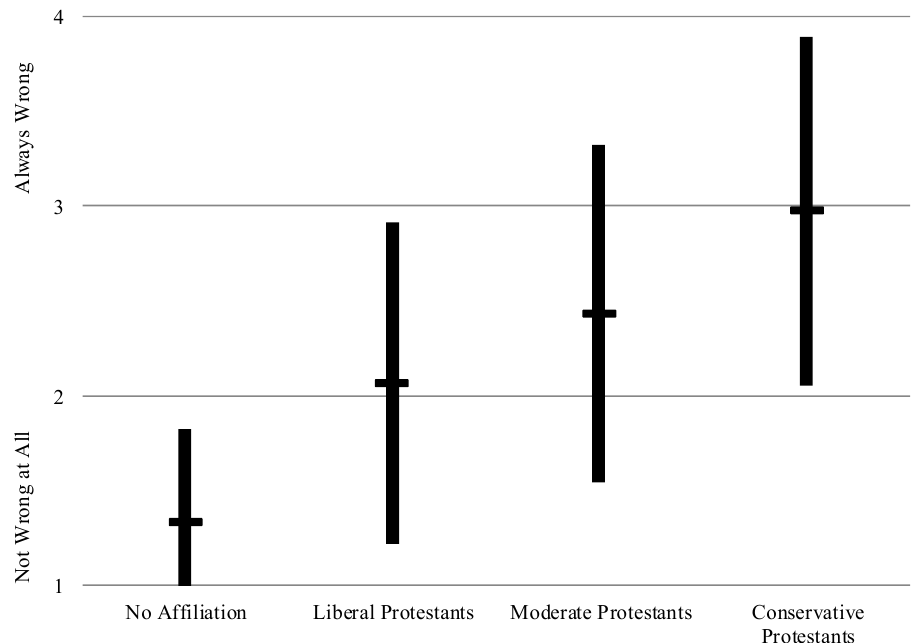
Figure 3. Individual views on Premarital Sex (Means of responses ± 0.75 standard deviation). All differences are significant at the 0.05